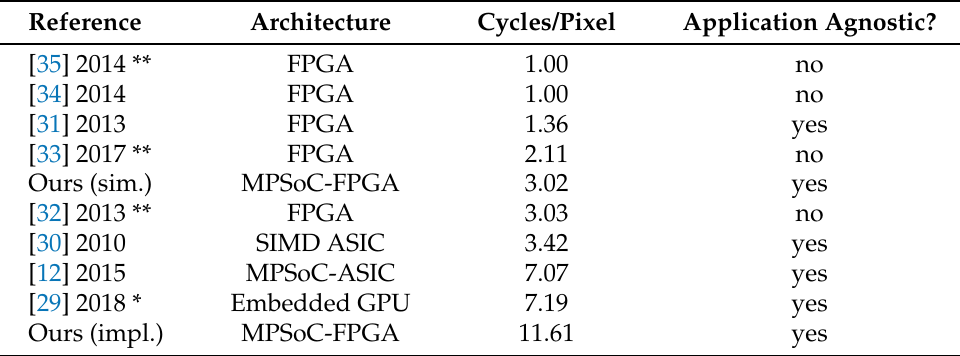
Table 5. Comparison of implementations of the